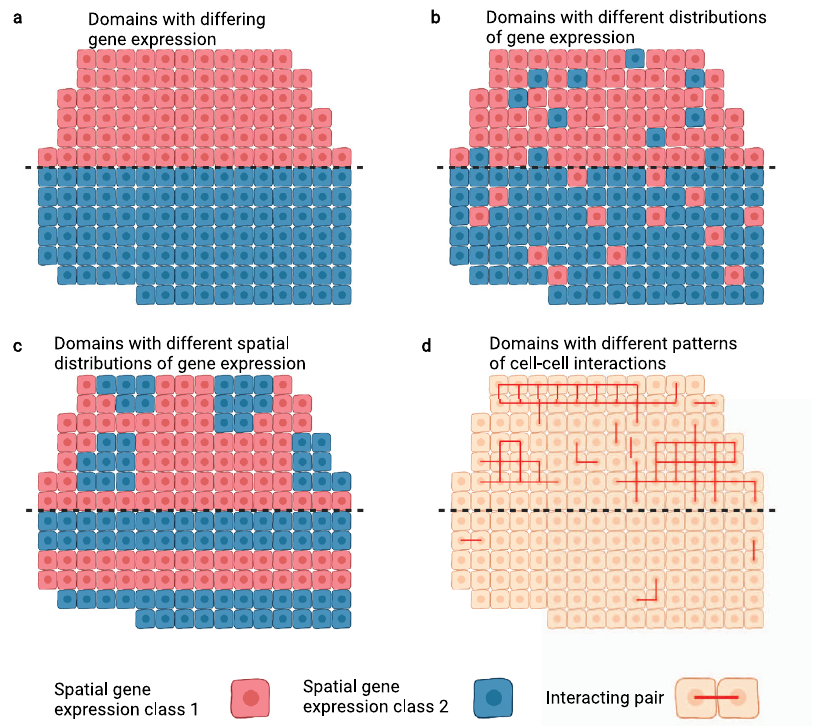
Fig. 2 Illustration of different traits that can separate spatial regions. a – d Dotted line indicates division between two regions. Red and blue cells indicate groups with consistent expression across some set of spatially variable genes. a Regions are characterized by different gene expression, equivalent to the groups identi fi ed by cluster analysis such as the Louvain algorithm on non-spatial data. b Regions are not entirely homogeneous, but instead differ in distribution of observed expression. c Regions have similar distributions, but differ in the spatial patterning of gene expression. d Red lines connect interacting cells. Beyond cell type indicated by gene expression, regions may be distinguished by higher-level properties such as patterns of cell-cell interactions. Performing region identi fi cation downstream of other analyses could allow for detecting variance in such